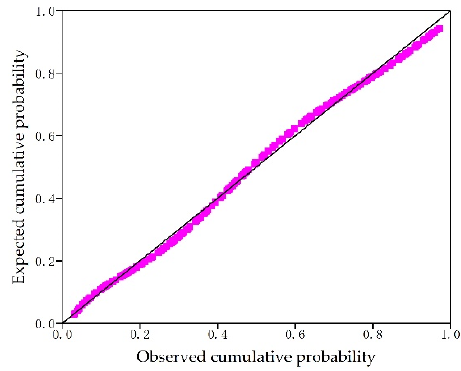
Figure 5. The normal probability–probability plot of standardized residual.